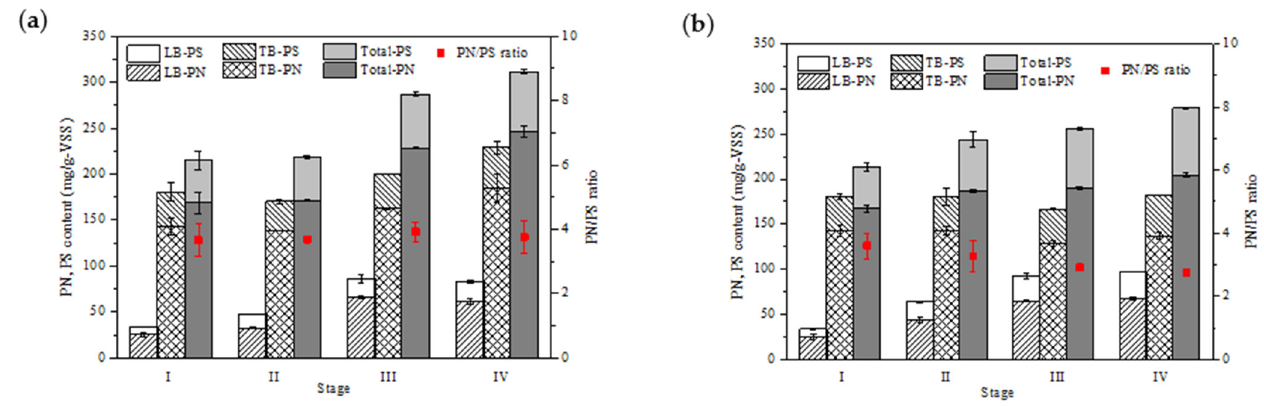
Figure 8. Variation of the EPS content (LB-EPS, TB-EPS, and total EPS), composition (PN and PS), and the PN/PS ratios of algal-bacterial AGS at the end of each test stage during the 28 days of operation. ( a ) R1; ( b ) R2.